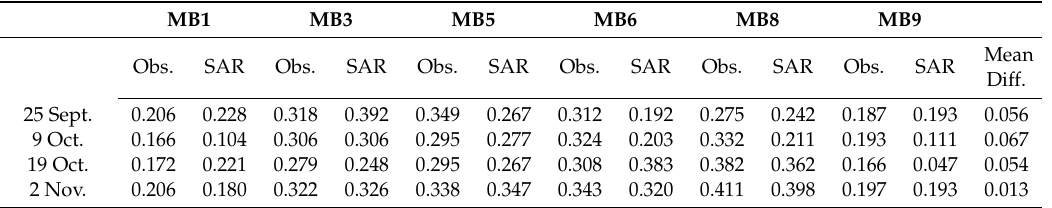
Table 2. Observed and retrieved soil moisture values at the six RISMA stations in m 3 m − 3